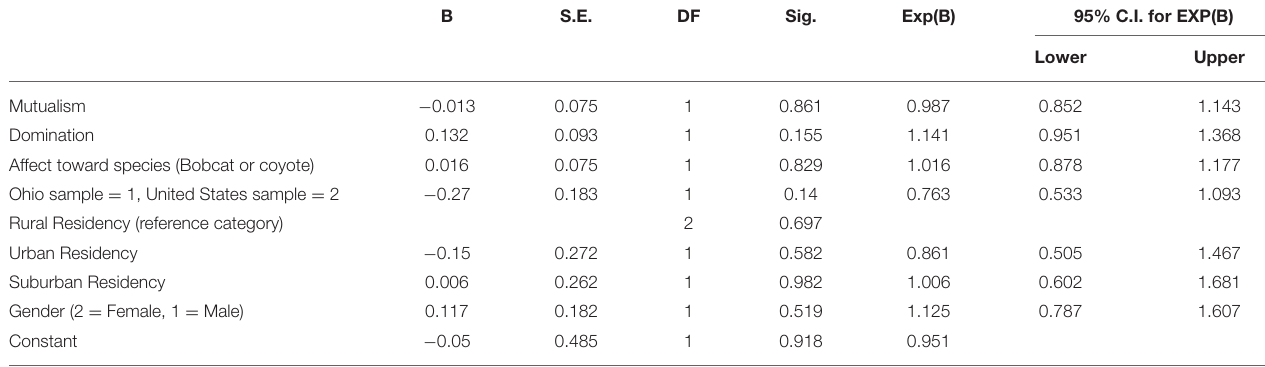
Table 3A | Binary logistic regression predicting the probability of contextual sensitivity or insensitivity using only cognitive and demographic predictors. B S.E. DF Sig.